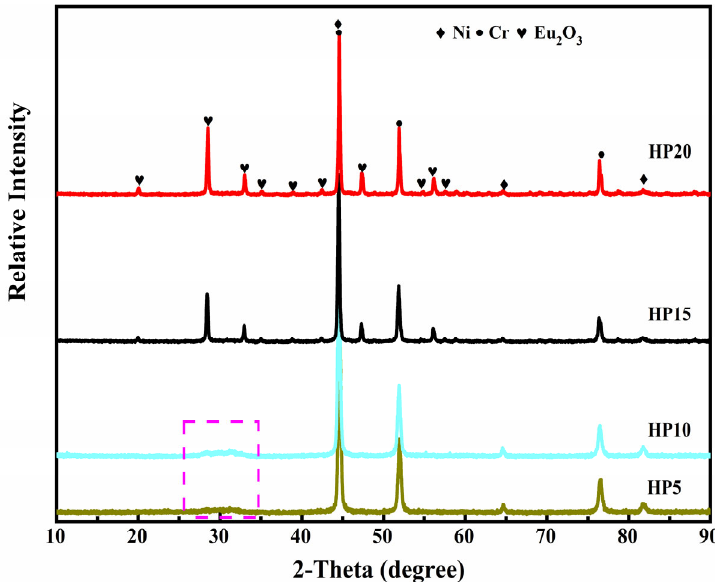
Figure 3. XRD patterns of as-milled